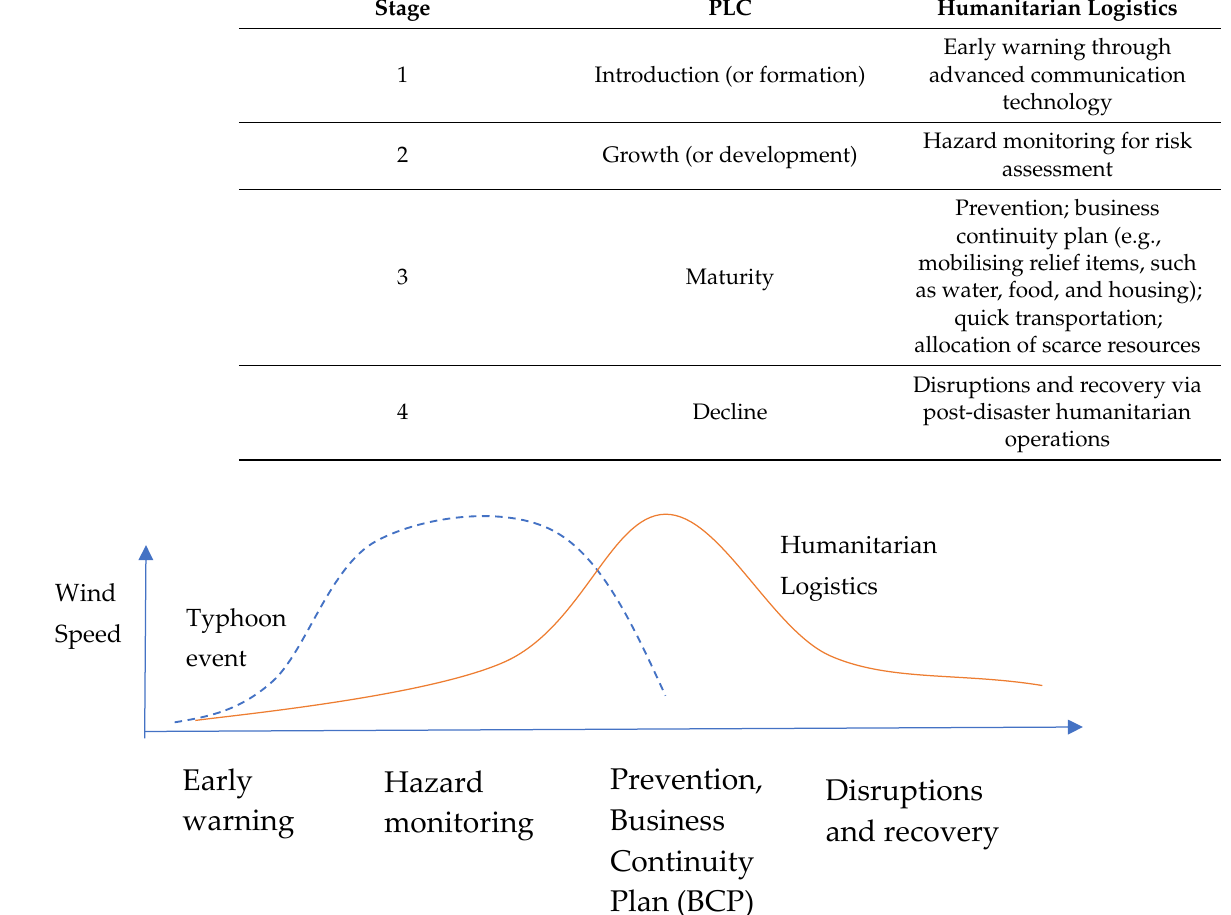
Table 2. The interface between a typhoon event and humanitarian logistics.